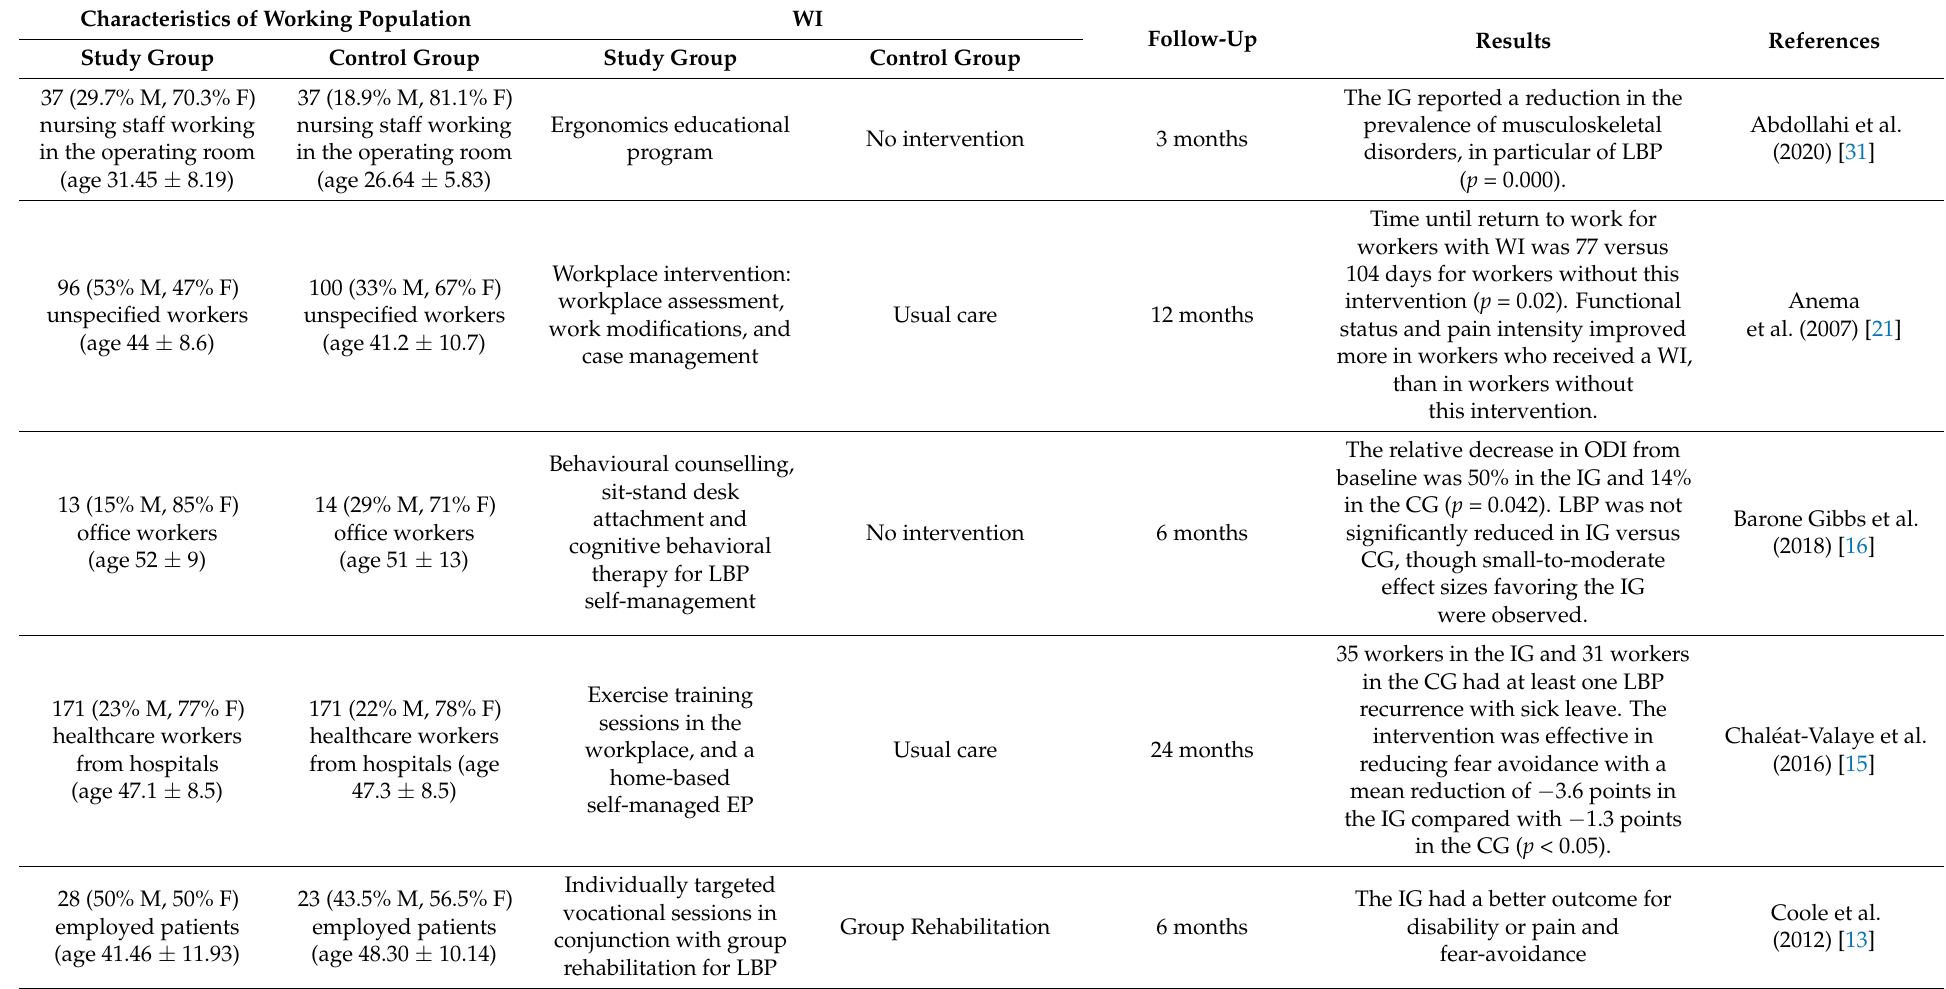
Table 1. Main characteristics and clinical results of the included